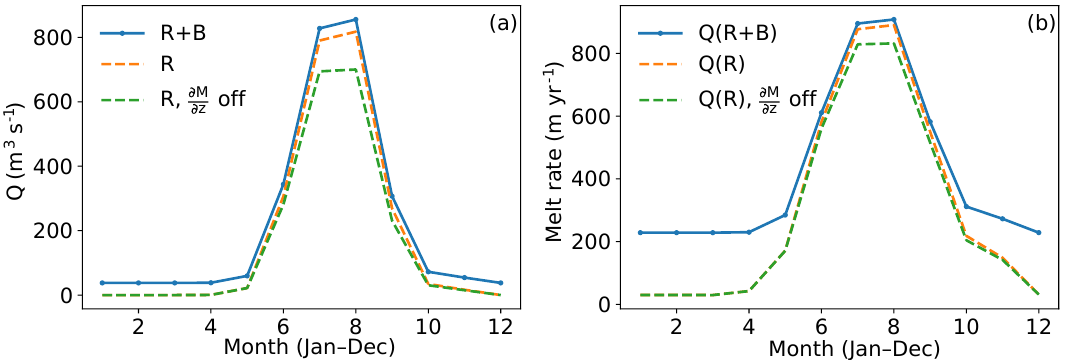
Figure 14. Subglacial discharge of Helheim Glacier (a) for the year 2000 determined by runoff ( R ) only (dashed lines), with and without surface elevation feedback (orange, green) and runoff together with basal melt ( R + B , blue solid line). The corresponding submarine melt rates (b) with the same line colour and line